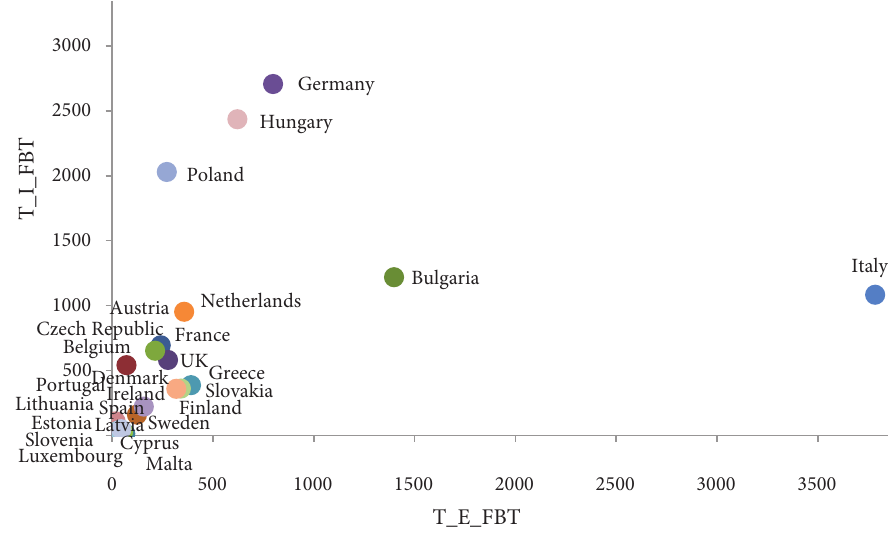
Figure 6. Romanian’s Total exports and Total imports of Food, beverages and tobacco with 26 countries of EU in 2007–2016 periods (mil. euro) (source: authors’ own design) Romania has a positive trade balance for food, beverages and tobacco, with 7 states (Bul- garia, Cyprus, Estonia, Greece, Italy, Latvia, Lithuania), with excess balances ranging from 4 mn. euro (Greece), to 2,701 mn. euro (Italy). With Malta the trade balance is zero, and the balances with the other 16 states the balances are negative, with deficits between 1,907 mn. euro (Germany) and 1 mn. euro (Finland). This compounds a total negative trade balance with all 26 states, the total deficit for food, beverages and tobacco standing at 5,062 mn euro, of which more than half comes from the trade flows of T_I_FBT and T_E_FBT